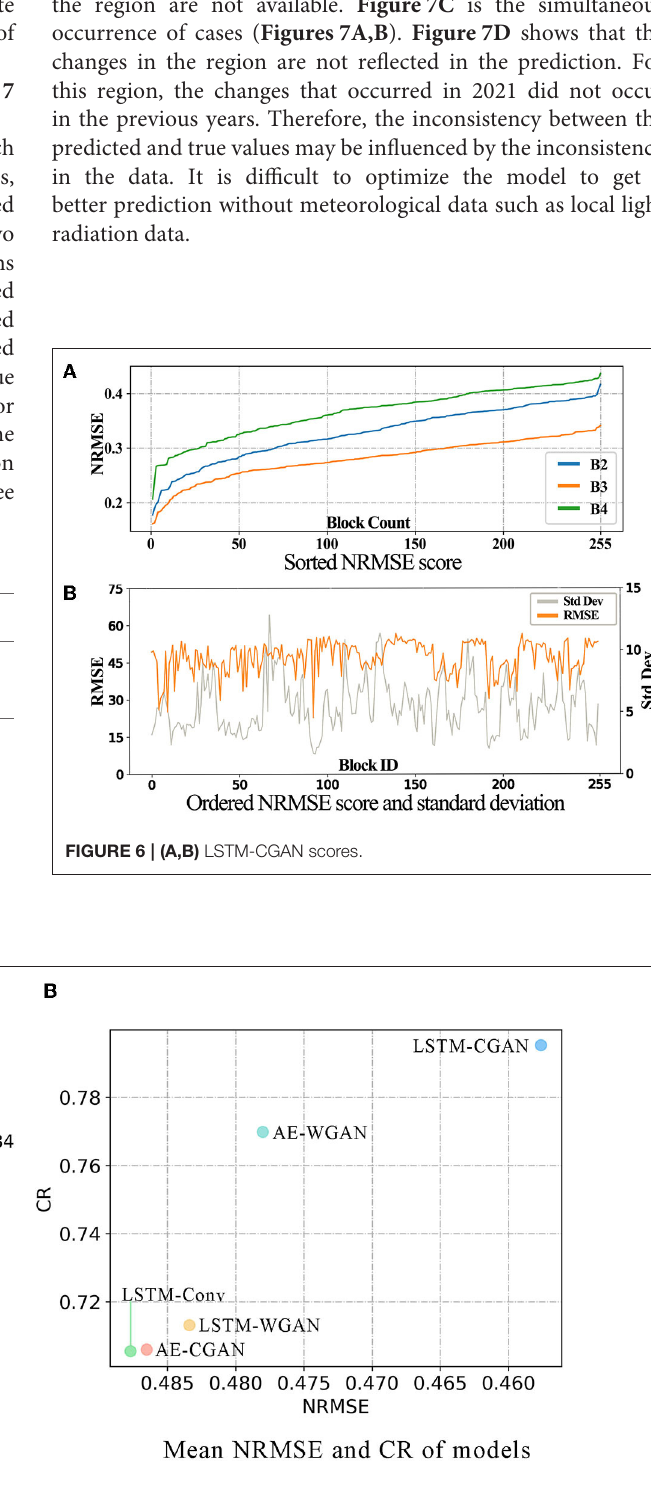
FIGURE 5 | (A,B) NRMSE and CR of